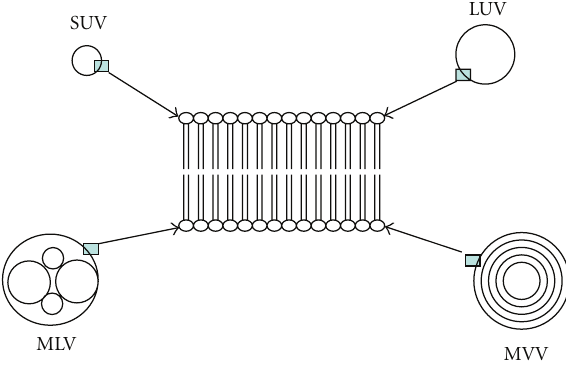
Figure 2: The classification of liposomes. SUV: small unilamellar vesicles; LUV: large unilamellar vesicles; MLV: large multilamellar vesicles; MVV: multivesicular